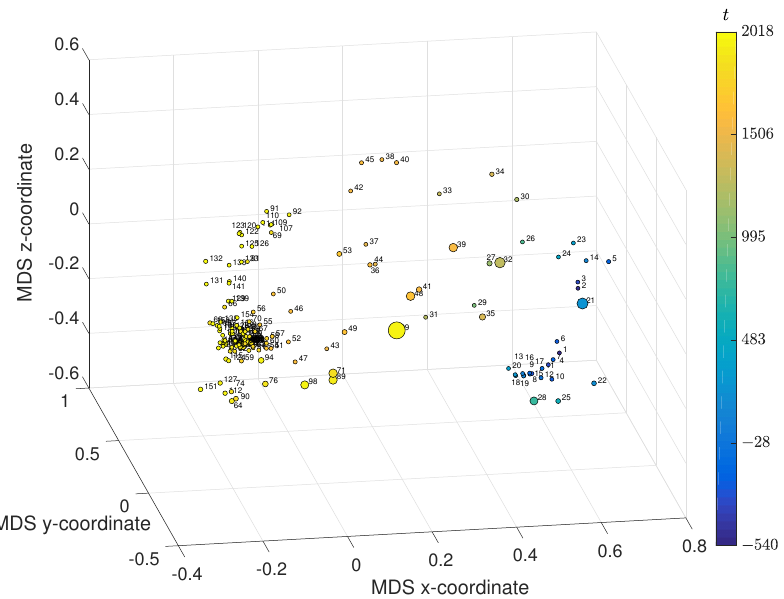
Figure 5. The 3-dimensional MDS loci obtained with the Sørenson distance, d 9 . The spheres represent wars, with size proportional to the number of casualties, C , and color proportional to time (years), t .